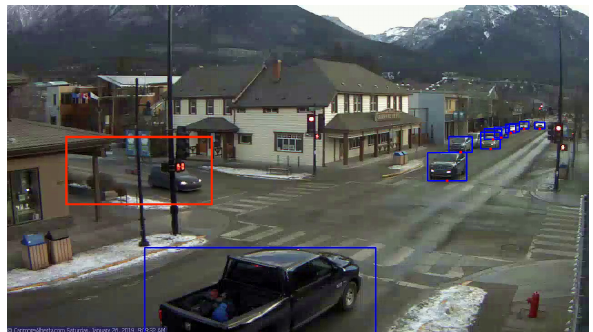
Figure 12. Problematic detection area (red)